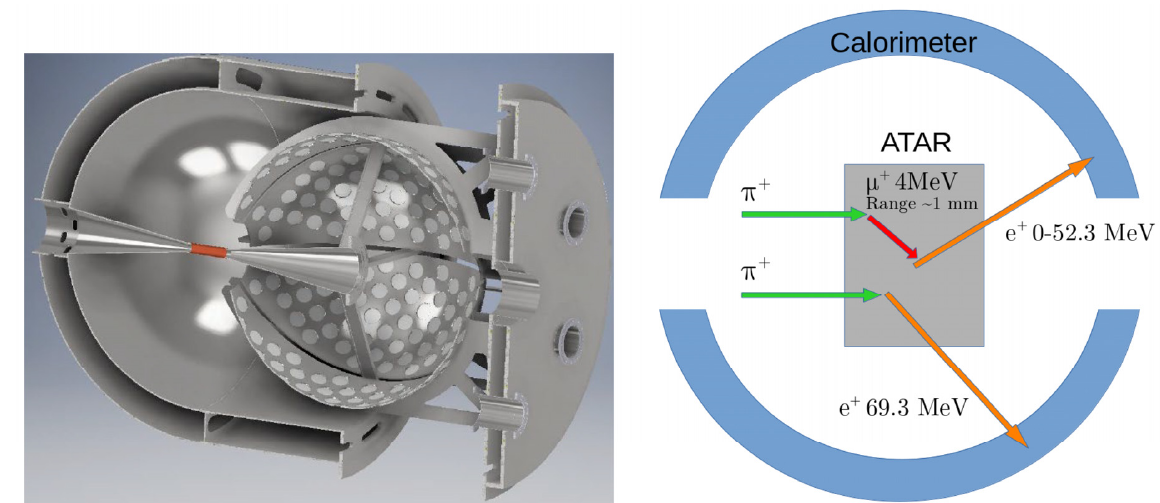
Figure 1. ( Left ) External enclosure for PIONEER calorimeter and ATAR. ( Right ) Pion decay to muon or electron in the ATAR and